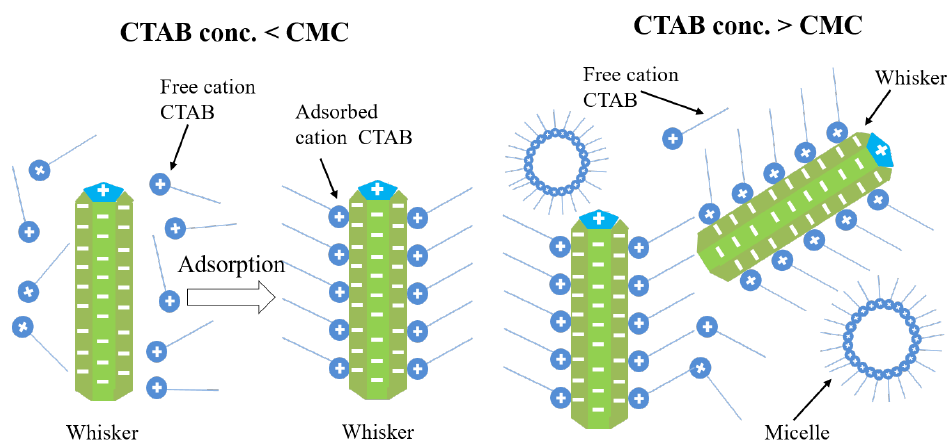
Figure 6. Adsorption sketch of CTAB on α-CaSO 4 ·0.5H 2 O whisker surfaces. CMC: critical micelle concentration.